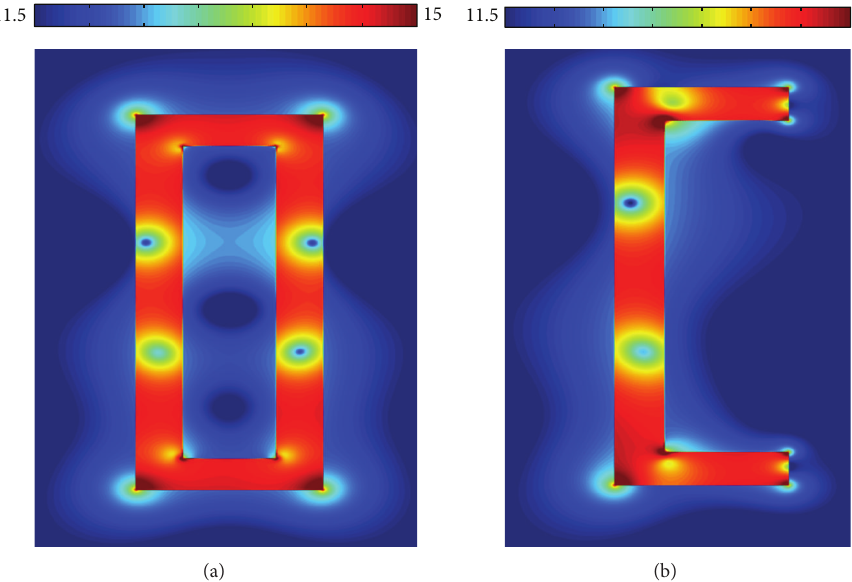
Figure 4: Spatial map of power absorption in logarithmic scale for a (a) core-shell nanowire (120 × 40) at 𝜆 = 951 nm. (b) half-shell nanowire (120 × 35) at 𝜆 = 946 nm. Shell thickness was